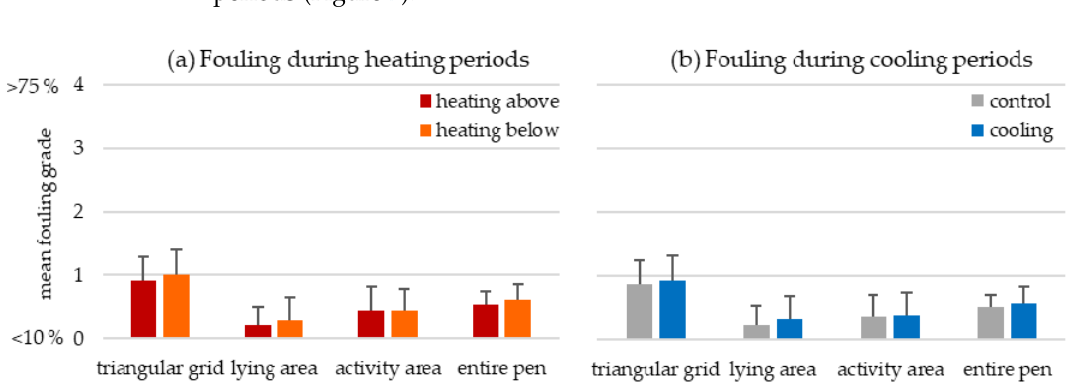
Figure 7. Mean fouling grade of the lying area, the activity area, the triangular grid, and the entire pen. ( a ): Data of pens with the two heating systems; ( b ) data of control pens or pens with a cooled lying area. Every bar represents data of n = 42 observations.